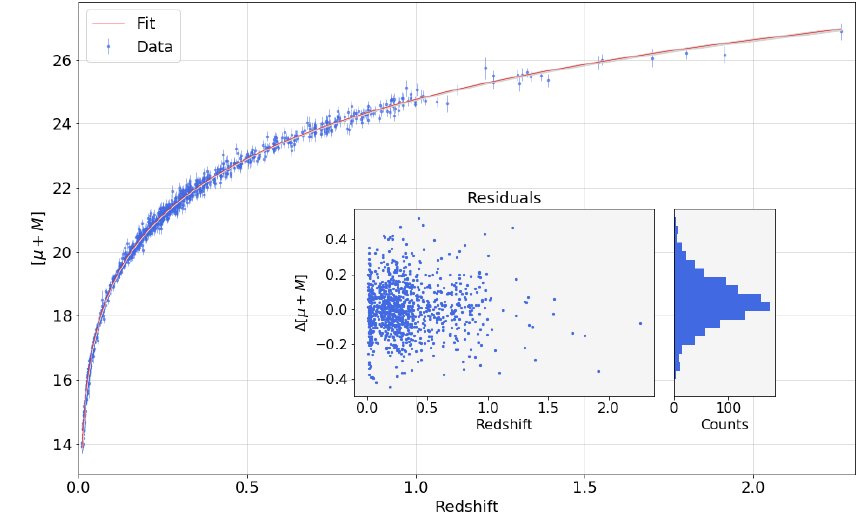
Figure 2. Fitted curve for GR standard model assuming M V = − 19.23. On the right corner, the residual plot for the fitted